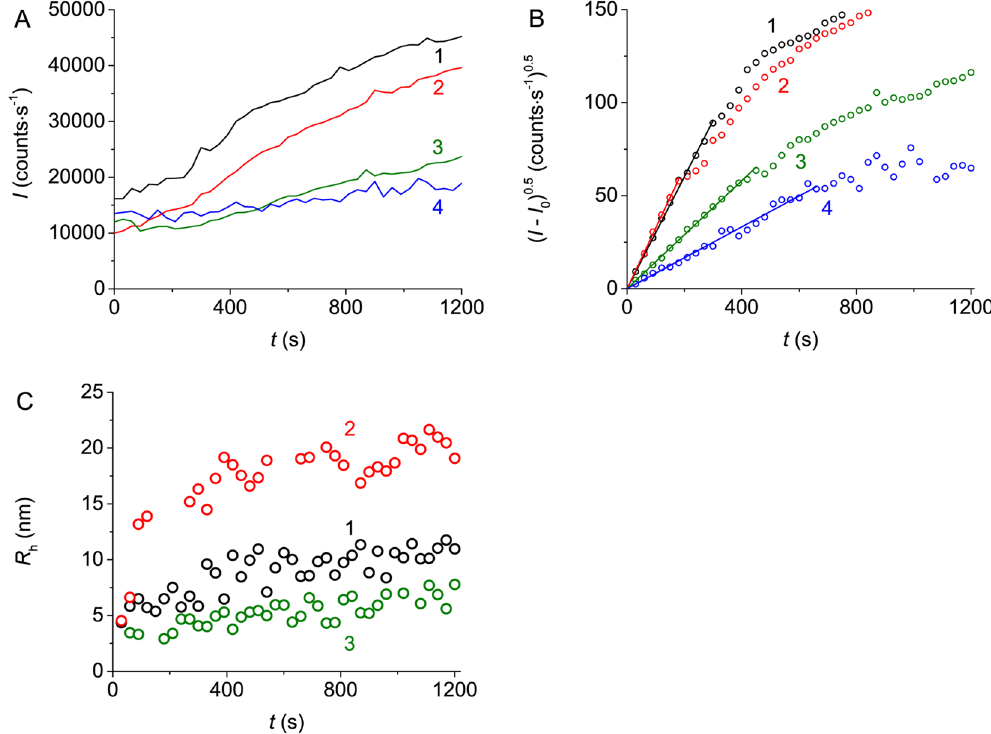
Figure 3. Effect of Arg on the kinetics of aggregation of BSA (1 mg∙mL − 1 ) registered by DLS (0.1 M Na- phosphate buffer, pH 7.0, 70 °C). ( A ) The dependences of the light scattering intensity ( I ) on time obtained at the following concentrations of Arg: 0 (1), 50 (2), 350 (3) and 1000 mM (4). ( B ) The kinetic curves represented in the coordinates {( I − I 0 ) 0.5 ; t }. Concentrations of Arg: 0 (1), 200 (2), 350 (3) and 1000 mM